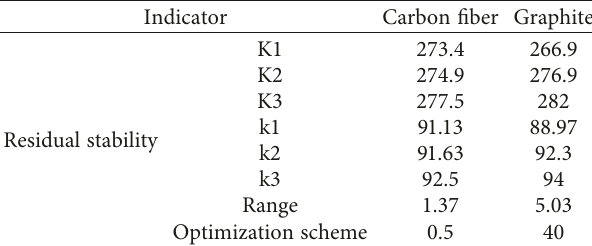
Table 13: Range analysis of immersion Marshall test.